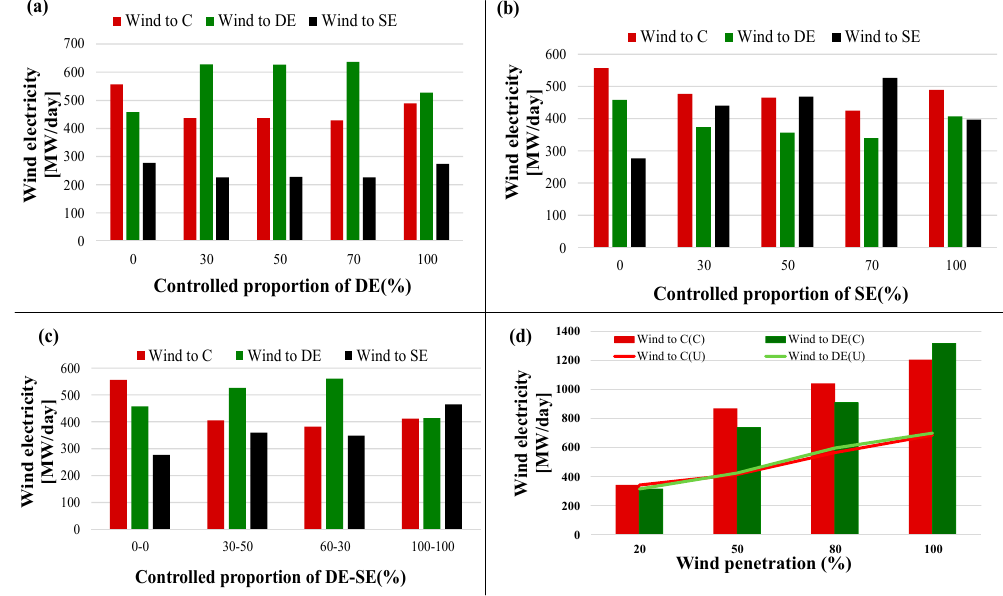
Figure 14. Wind electricity dispatch results for ( a ) Case-2, scenarios A; ( b ) Case-2, scenario B; ( c ) Case-2, scenario C; and ( d ) Case-3.